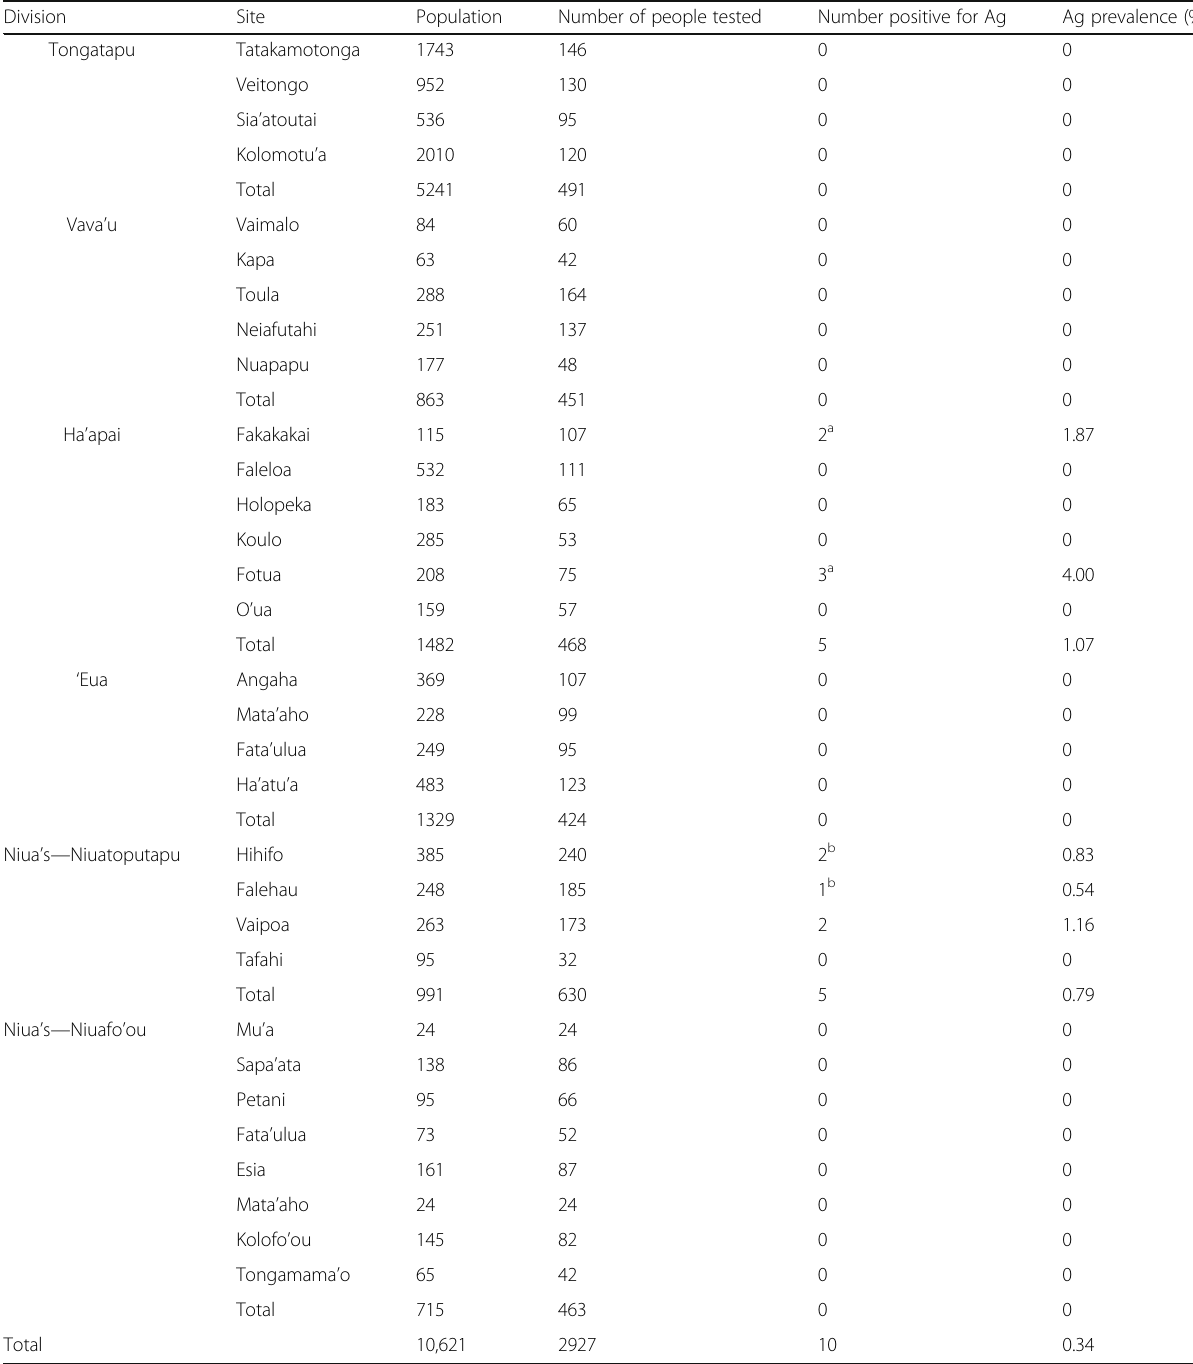
Table 5 Detailed results of C survey in Tonga, 2006